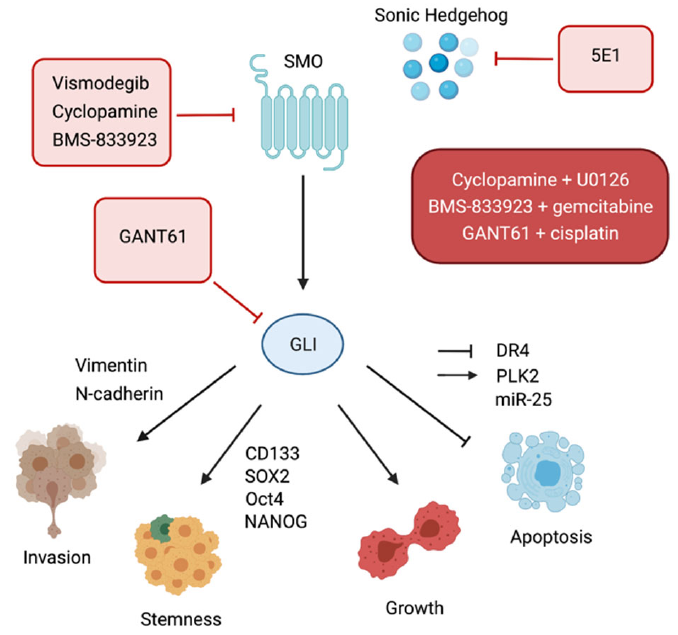
Figure 2. Schematic representation of the Hedgehog pathway and its functions in CCA. The HH signaling regulates growth, survival, stemness, and invasiveness in cholangiocarcinoma cells. HH pathway antagonists used in CCA preclinical studies are acting at the level of SHH (5E1 anti-SHH antibody), SMO (vismodegib, cyclopamine, BMS-833923), and the GLI (GANT61). They have been tested alone or in combination with other targeted molecules (U0126) or with chemotherapeutic drugs (gemcitabine, cisplatin) in vitro and in vivo. Proteins that are illustrated as HH downstream targets have been demonstrated to be modulated directly by transcriptional binding of GLI (DR4, PLK2) or as a final effect of the pharmacological inhibition of the HH cascade in CCA